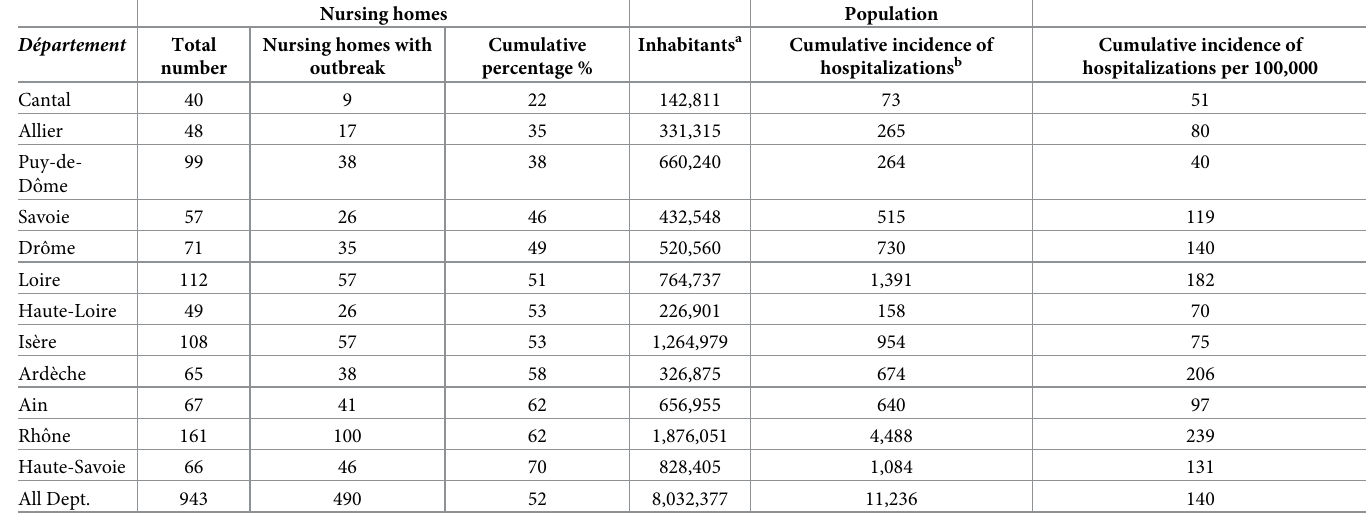
Table 1. COVID-19 cumulative outbreaks in nursing homes and cumulative incidence of inhabitant hospitalizations for COVID-19 in the Départements of Auvergne-Rhoˆne-Alpes Region, France, March 1–July 31, 2020.